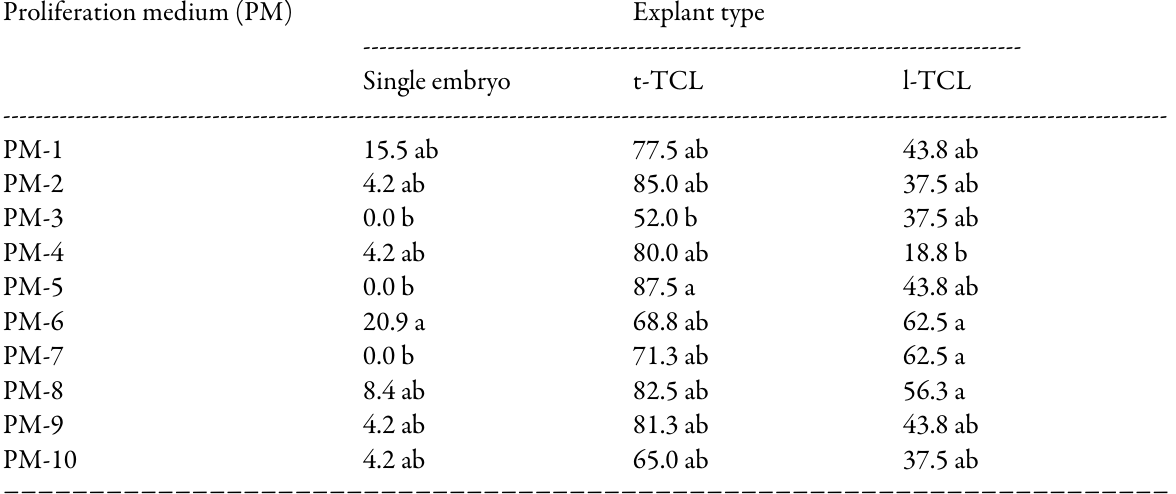
Table 3. Interaction effect of explant types and proliferation media on percentage of explant browning (%) Proliferation medium